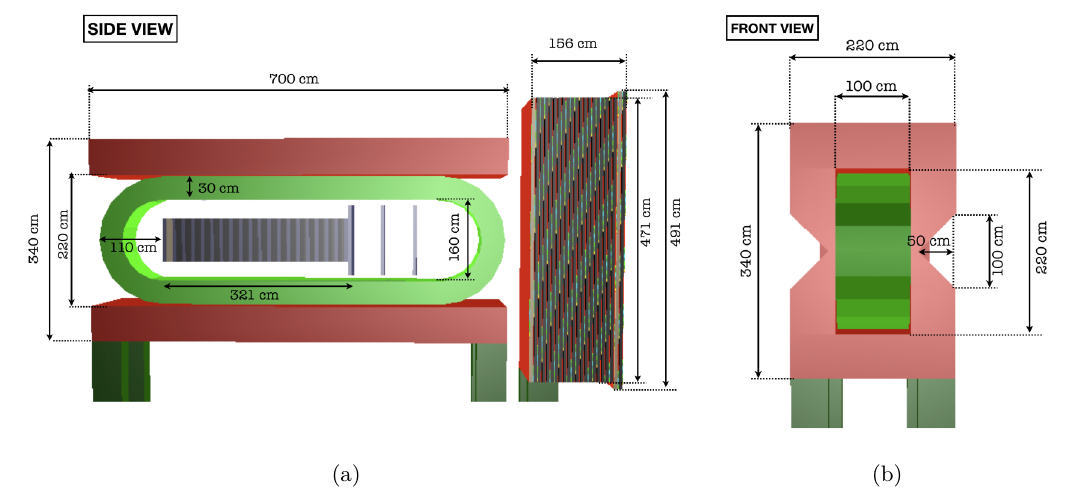
Figure 2. Side (a) and front (b) views of the Scattering Neutrino Detector layout adopted for this study, with a detail of the magnet (red) and of the coil